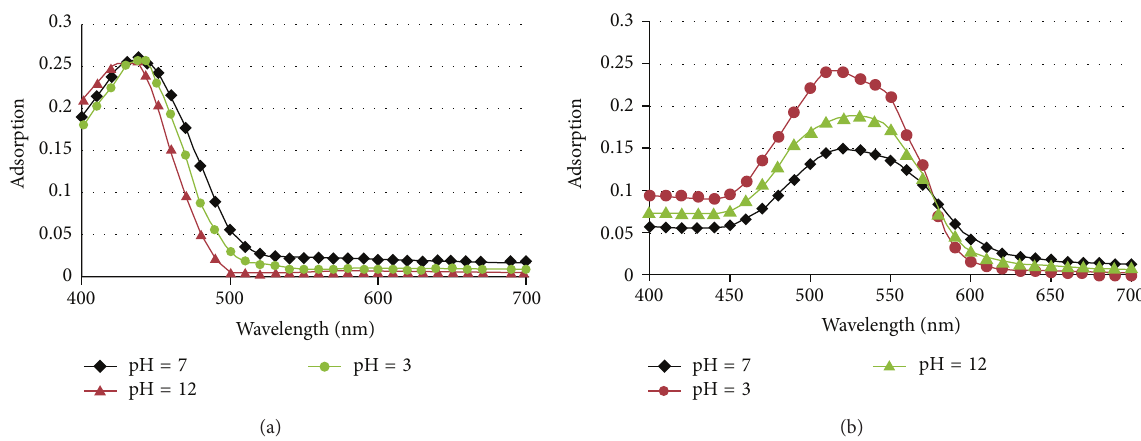
Figure 1: Effect of pH solution on the 𝜆 max adsorption behavior for (a) Solophenyl Red 3BL and (b) Polar Yellow GN.